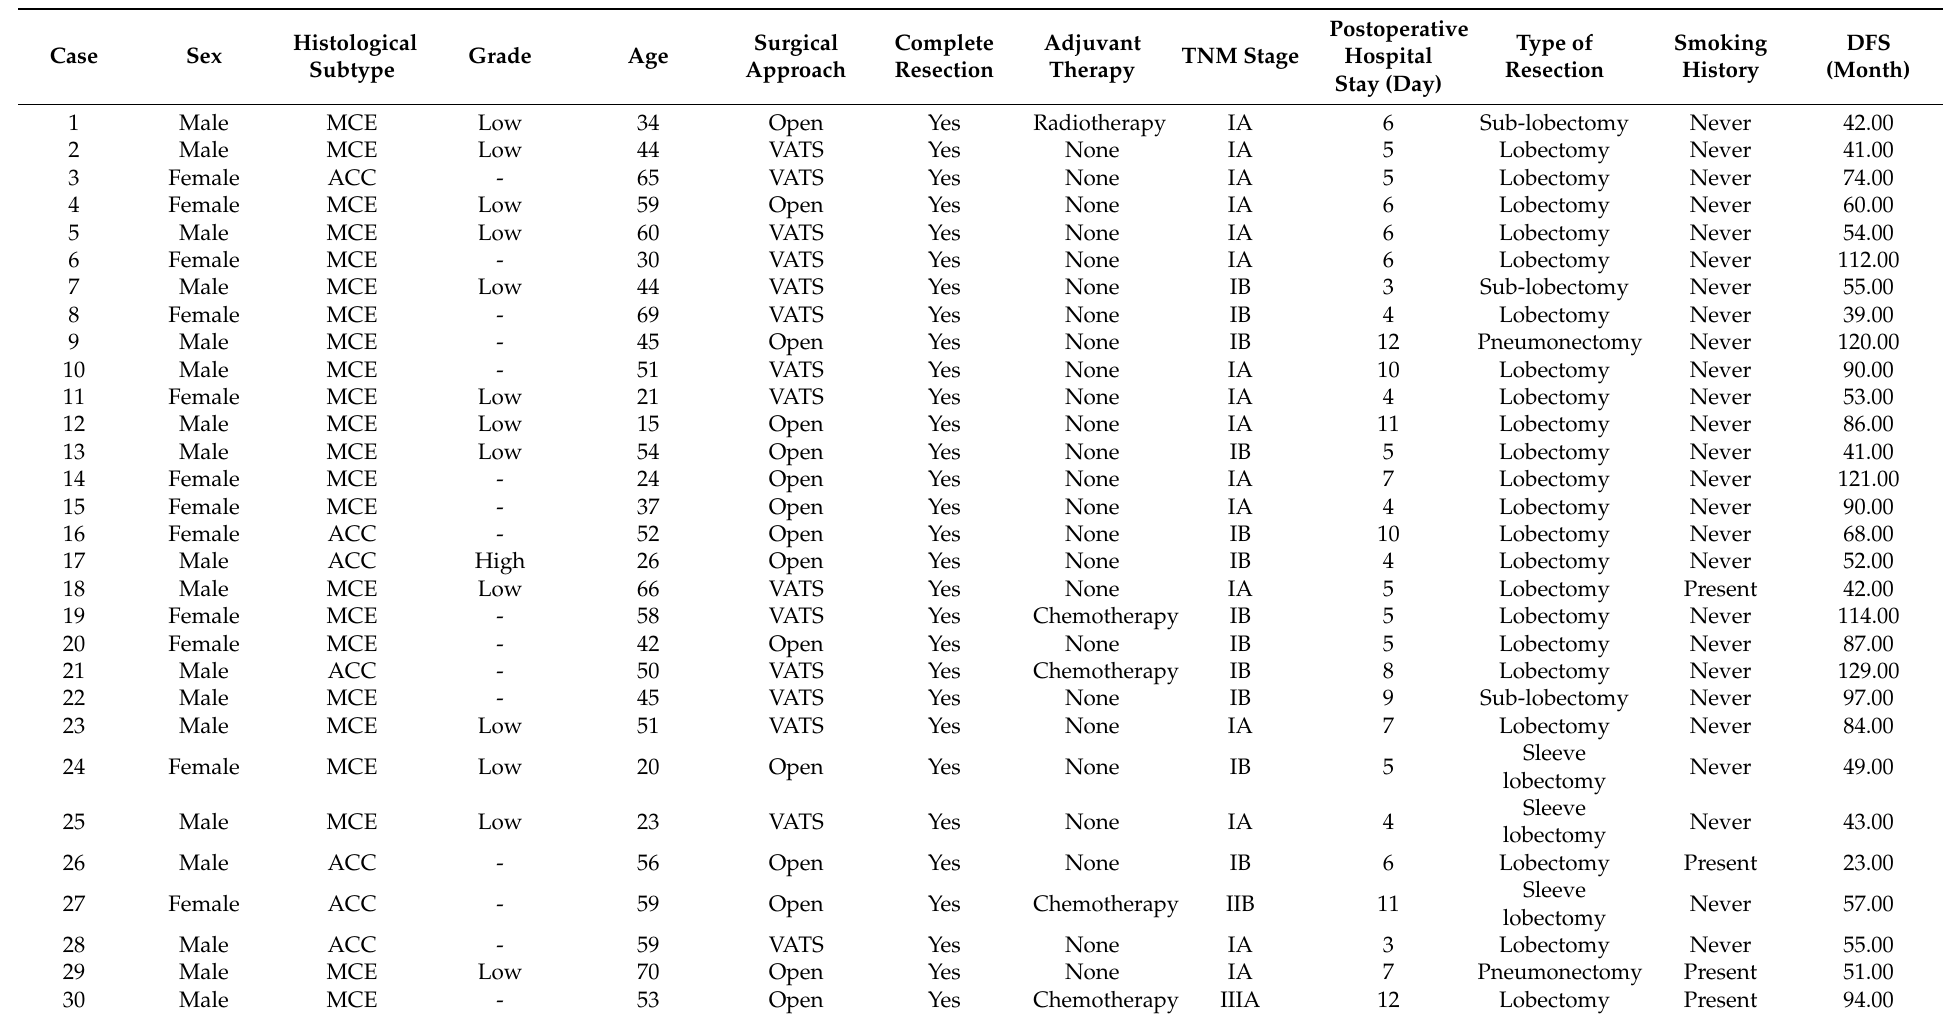
Table 2. Detailed information about pulmonary salivary gland-type carcinoma in Shanghai Pulmonary